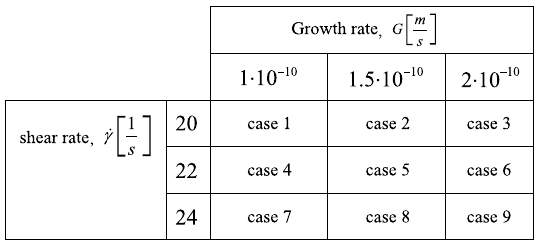
Table 1 Parameters for the 9 cases simulated in this study